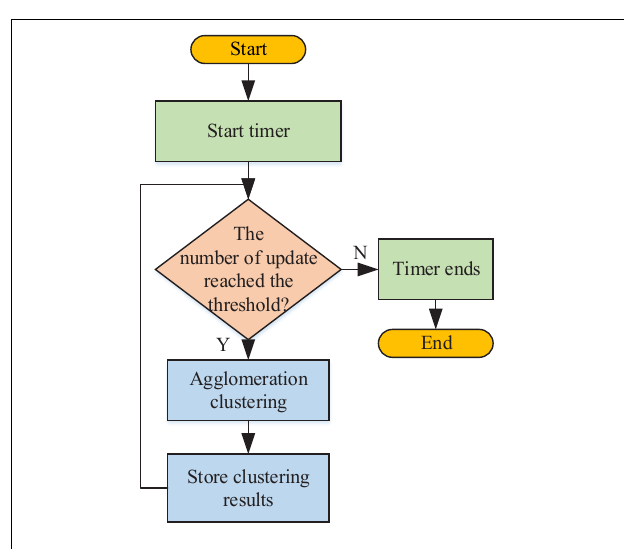
FIGURE 8 | Working flowchart of clustering